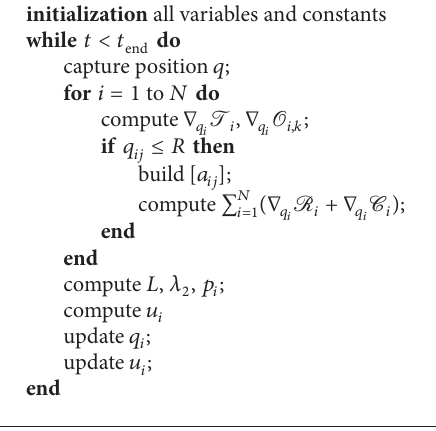
Algorithm 1: Main